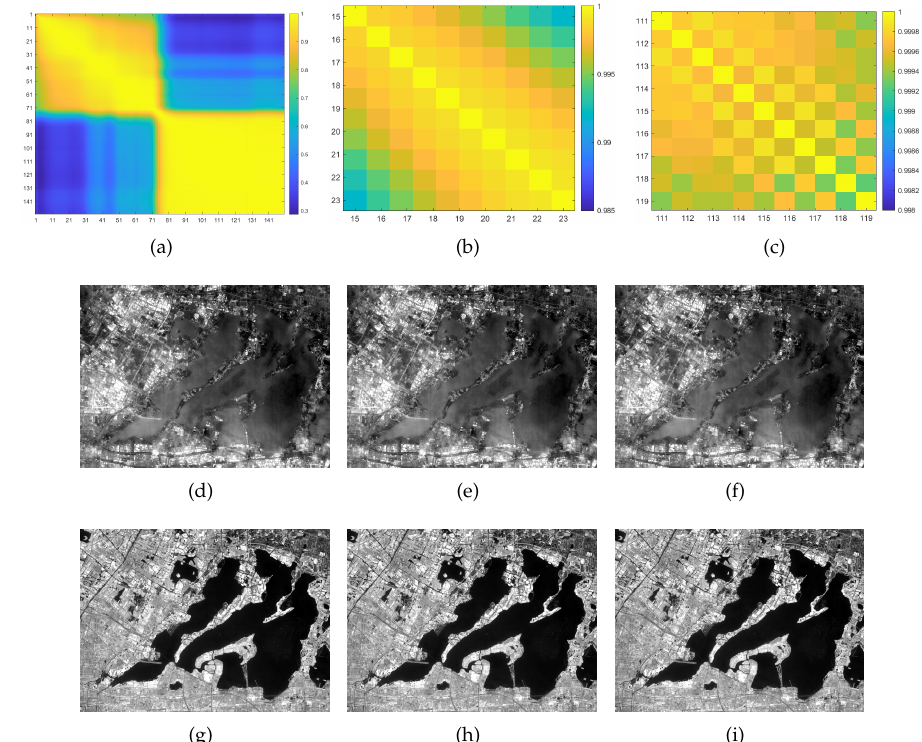
Figure 7. For the YC Lake data with 150 bands, ( a ): the correlation coefficient image between the spectral bands with a size of 150 × 150; ( b ): the correlation coefficient image of Band 15–24; ( c ): the correlation coefficient image of Band 111–120; ( d – i ): the gray image for Band 19–21, 113–115. The corresponding correlation coefficient between Band i and j (denoted ρ i , j ) are attached: ρ 19,20 = 0.9989, ρ 19,21 = 0.9987, ρ 20,21 = 0.9990, ρ 113,114 = ρ 114,115 = 0.9996, ρ 113,115 = 0.9999.